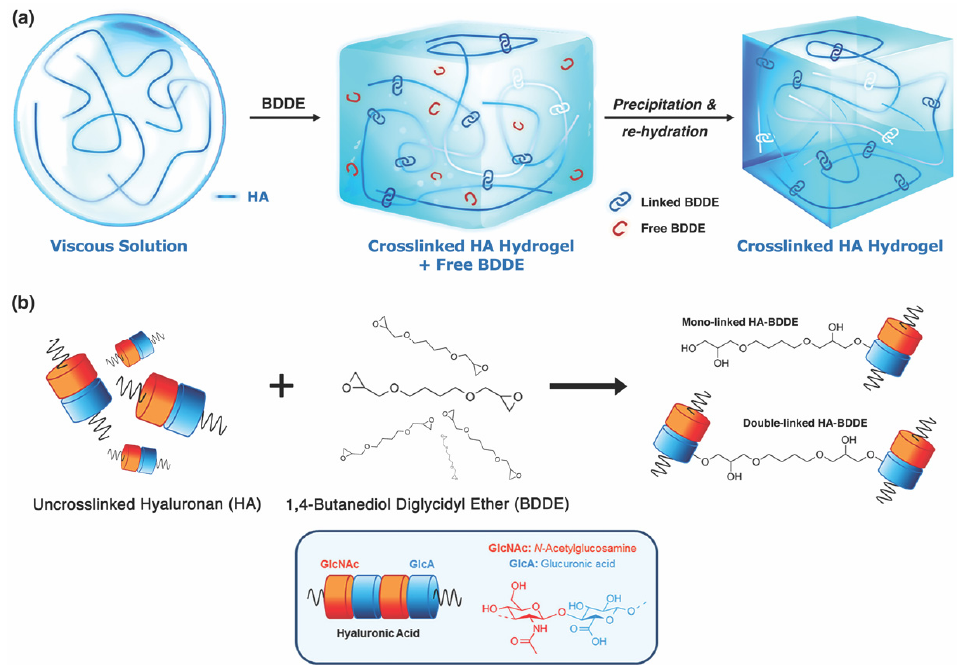
Figure 6. The synthesis and purification of crosslinked hyaluronan (HA) dermal filler hydrogels. ( a ) Uncrosslinked HA aqueous solution, a viscous fluid, is combined with 1,4-butanediol diglycidyl ether (BDDE), subsequently precipitated, and re-hydrated, yielding the finished product. The free, unlinked BDDE is eliminated from the final hydrogel. ( b ) Schematic representation of the molecular interaction of BDDE with HA molecules, yielding mono- and double-linked HA. Adapted from Guarise et al. [89], with permission.